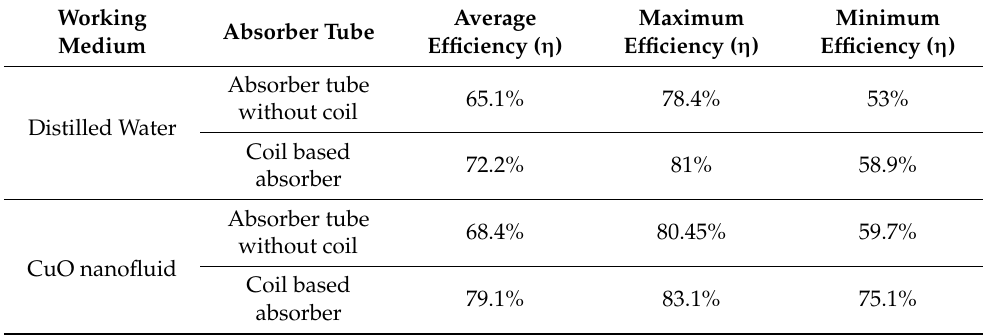
Table 3. Efficiency of absorber tube without coil and with coil using distilled water and CuO nanofluid as working